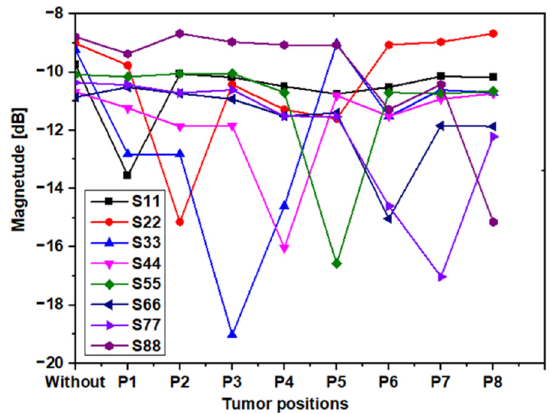
Figure 18. Experimental results of S ii in position 1.